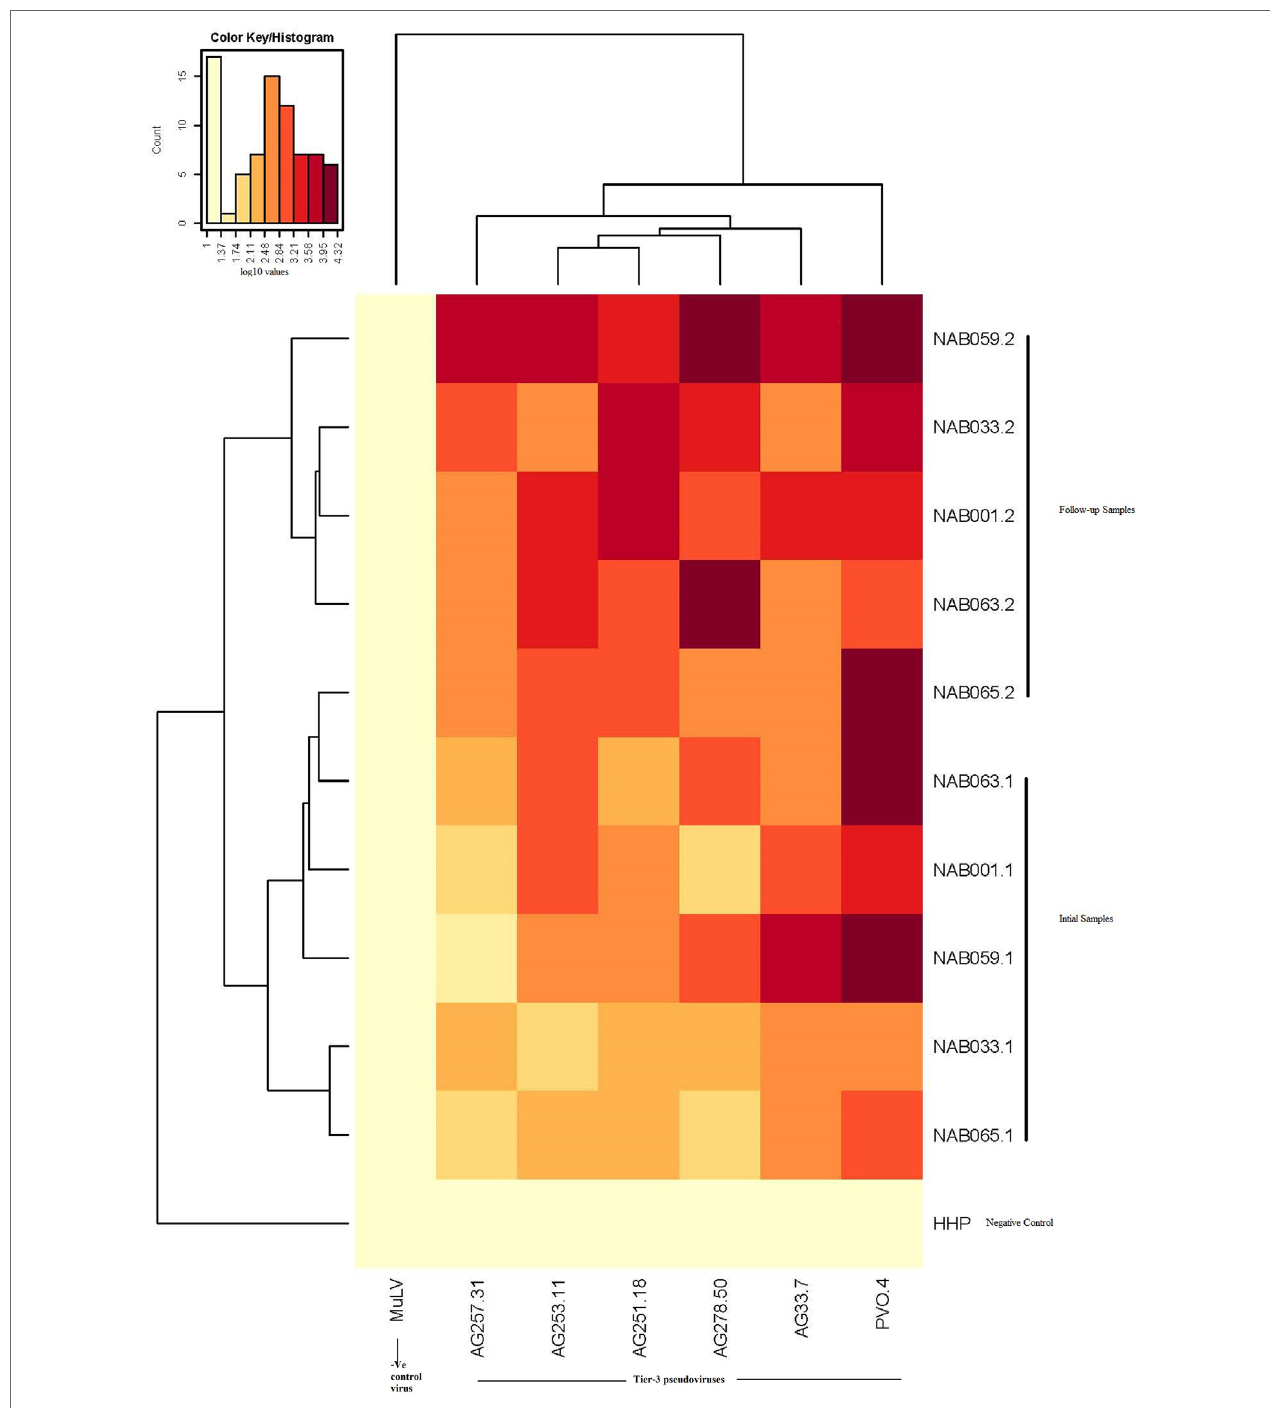
FigUre 1 | Heat map of the results of the neutralization assay of the follow-up samples tested against tier-3 pseudoviruses, and hierarchical clustering of plasma and viruses based on neutralization titers.